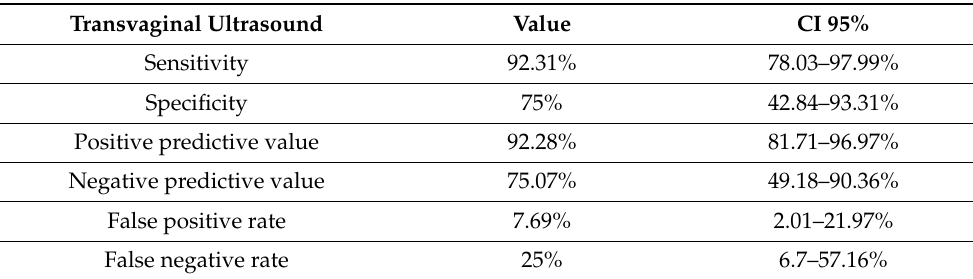
Table 5. Diagnostic values of transvaginal ultrasound for pelvic congestion syndrome using the criteria of any pelvic vein diameter of 8 mm or larger.